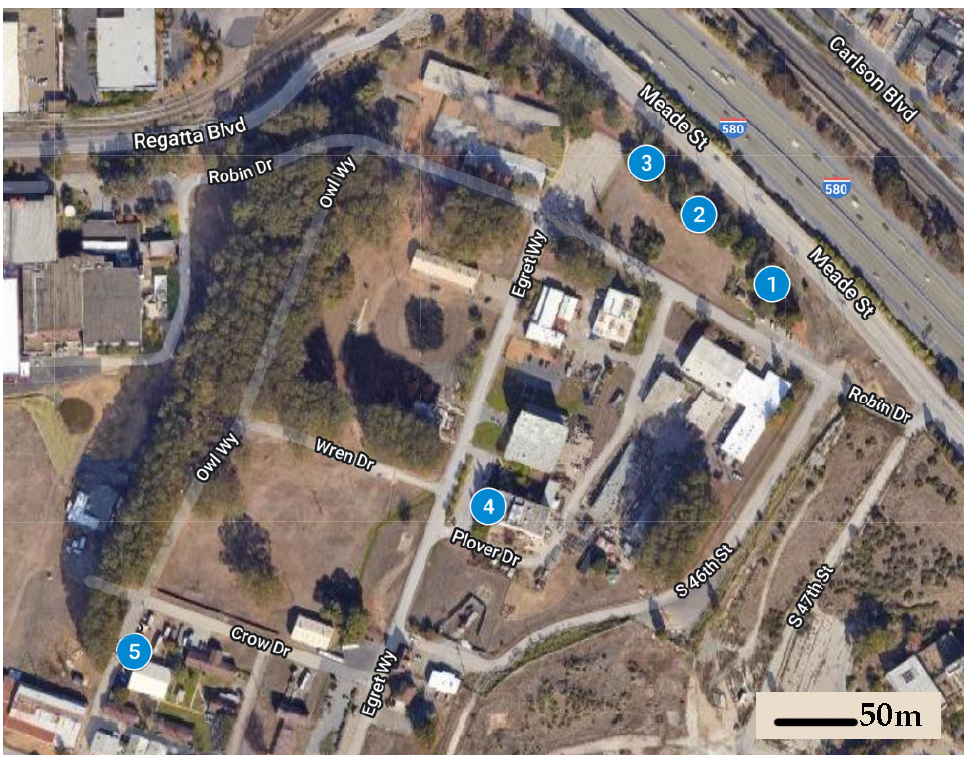
Figure 1. Five sites were established in 2019 at the University of California, Berkeley; Richmond Field Station; a sparsely-vegetated 40 ha property used for institutional and industrial purposes.